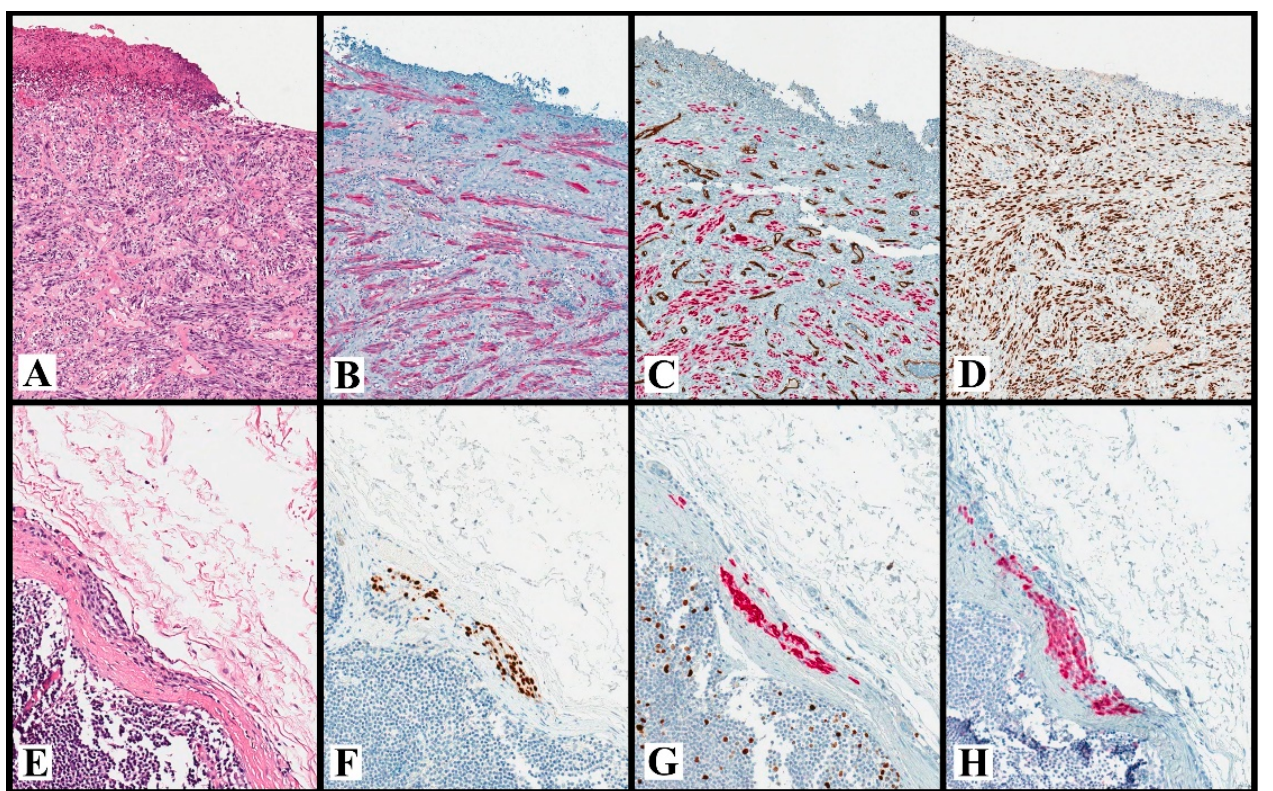
Immunohistochemical Markers